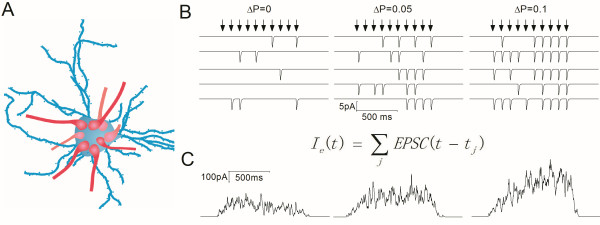
A principle for the integration of synaptic inputs on postsynaptic neurons by computational simulation. A) A neuron receives many synaptic inputs. B) These synapses in response to presynaptic manipulations possess the different changes in release probability (ΔP). The arrows present the firing of presynaptic spikes. C) shows the integrated current waveforms under the conditions of different release probabilities, based on the formula.